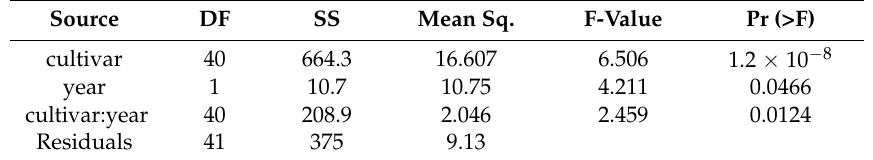
Table 5. Results of an analysis of variance (ANOVA) showing an interaction output for ε -viniferin content by year from different muscadine grape cultivars (2013–2015).